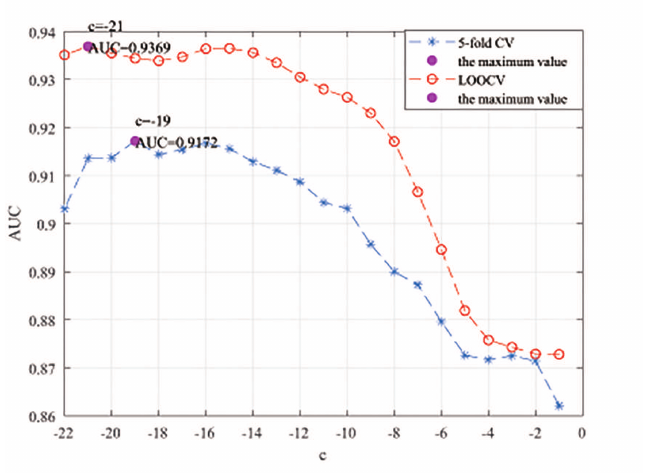
Figure 5. Sensitivity analysis of parameter c .